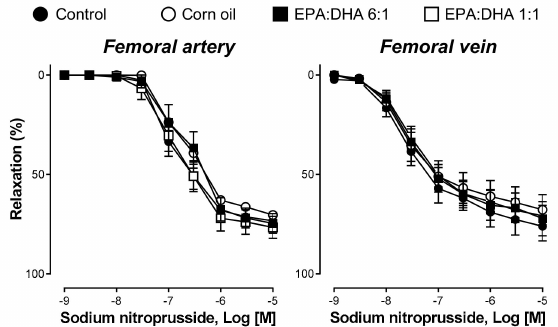
Figure 4. Sodium-nitroprusside-induced concentration-dependent relaxations of the femoral artery and vein of the control group, the corn oil group, and the EPA:DHA 1:1 and 6:1 groups. In the presence of indomethacin (10 µ M), TRAM-34 and UCL-1684 (10 µ M each), and L-NA (300 µ M), rings were precontracted with 5-HT (1 µ M) before the construction of a concentration–relaxation curve to sodium nitroprusside, a NO-donor. Results are expressed as percentage of relaxation and given as means ± S.E.M. of ten rats per